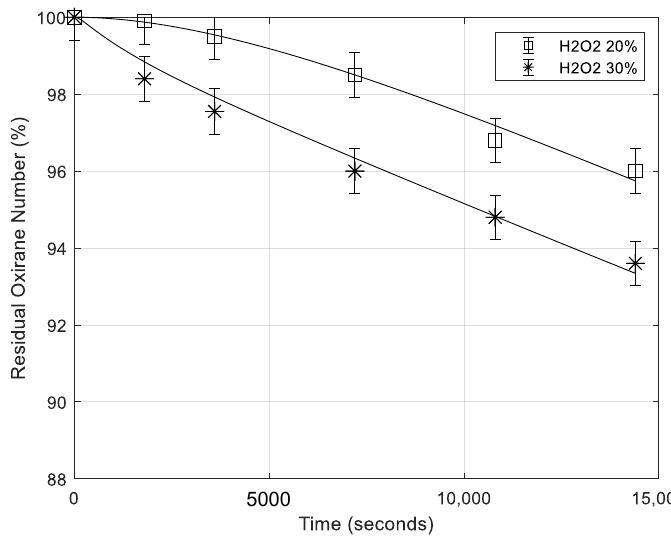
Figure 9. Residual oxirane profiles for different concentrations of hydrogen peroxide, being the same all the other conditions (mass of catalyst 0.65 g; rate of agitation 500 rpm; temperature 70 °C, mass of formic acid 5.16 g). Points are experimental data lines that are calculated with the developed model.